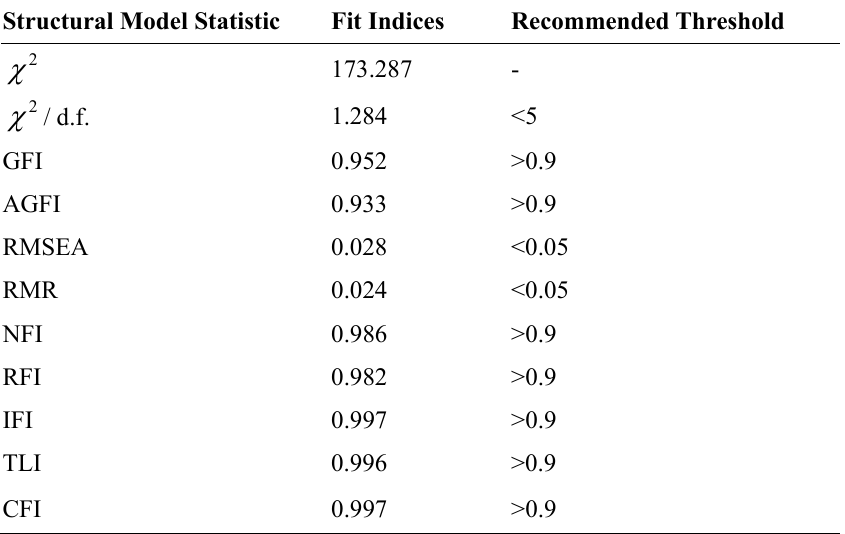
Table 4. Fit Indices for the Structural